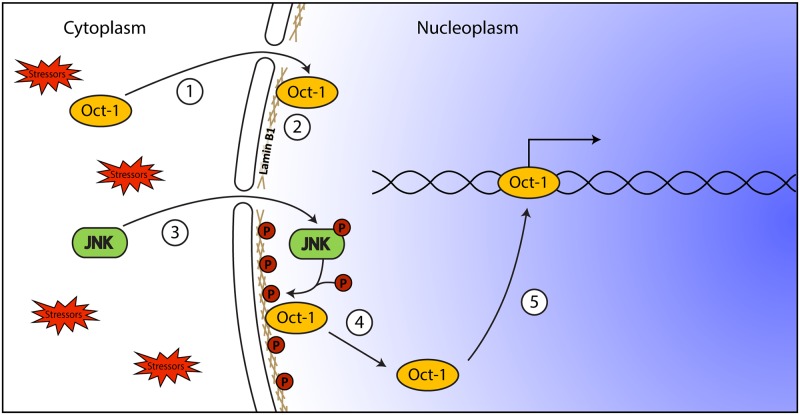
Schematic summary of main findings.Oct-1 that is imported into the nucleus (1) is tethered to the NE by interacting with lamin B1 (2). When cells are subjected to stress (e.g. MMS treatment), JNK is activated by phosphorylation (3) and in turn phosphorylates lamin B1 (4). The phosphorylation of lamin B1 results in release of Oct-1 from the NE and its binding to target sequences (5), regulating gene expression. Note that this generates a Boolean AND gate in which two events are required for full signalling, although they may occur independently in time and indeed in any order.